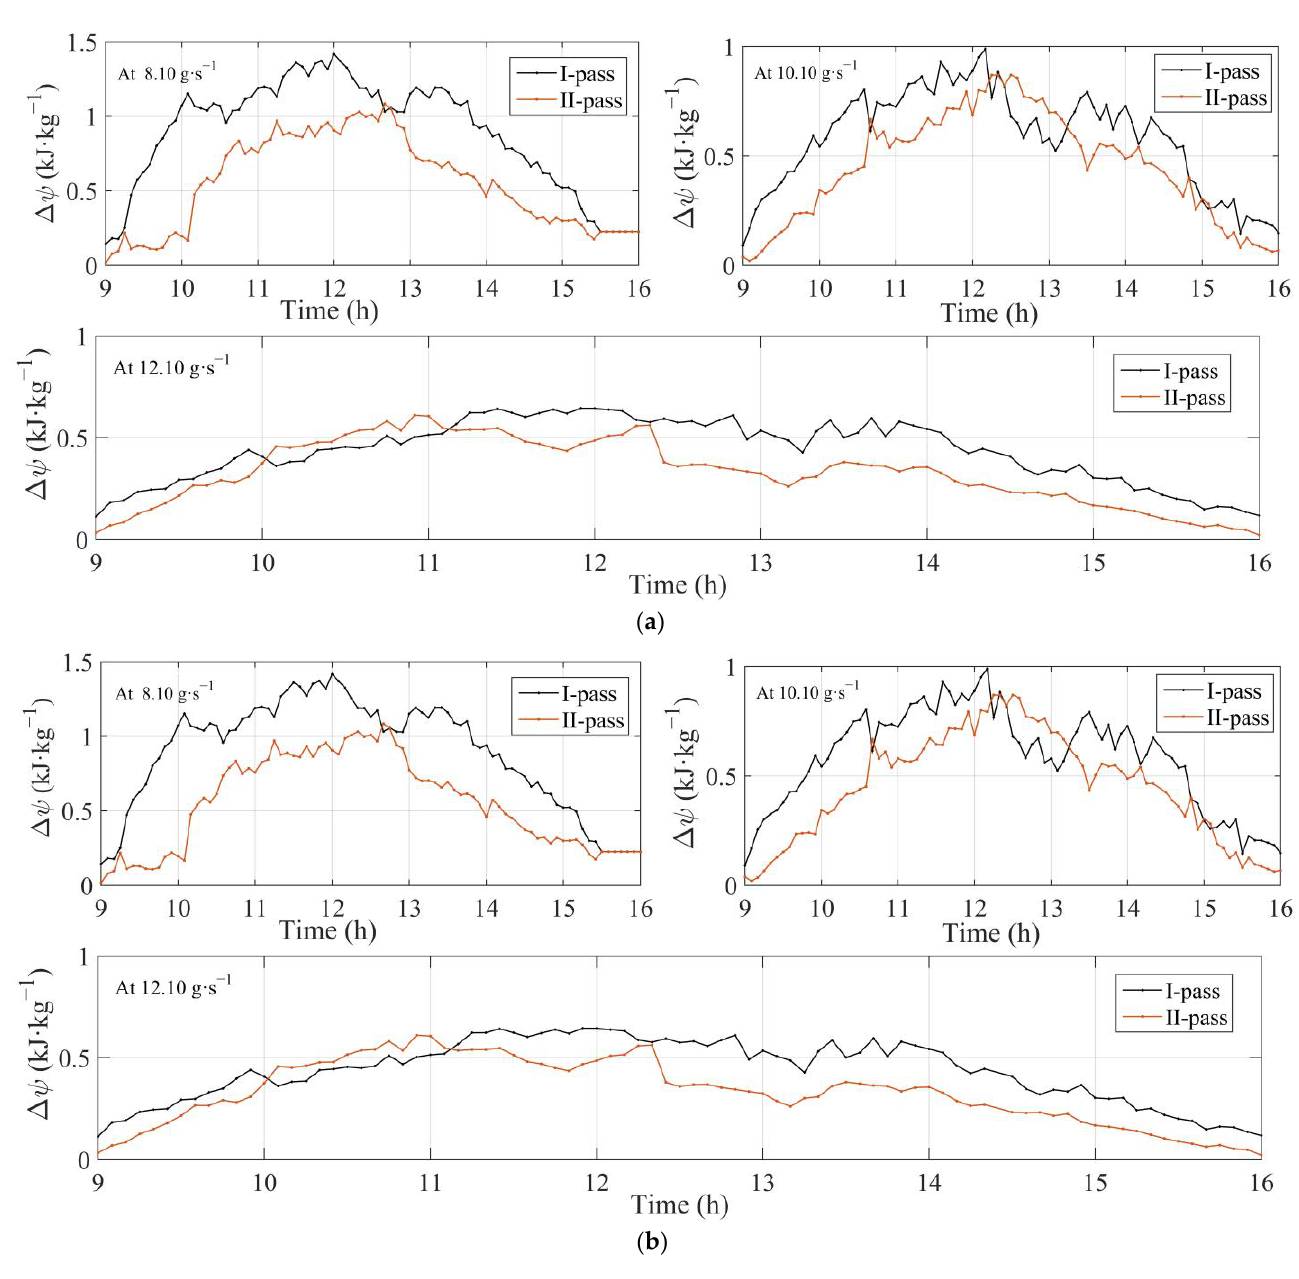
Figure 6. The change in exergy function (∆ ψ ) of the system with the air flow rate ( 𝑚̇ ) The change in the second law efficiency ( η II %) with time is illustrated in Figure 7. At 8.10 g∙s − 1 , the value of η II for Collector-II (I-pass) was estimated to be 36.16% higher than